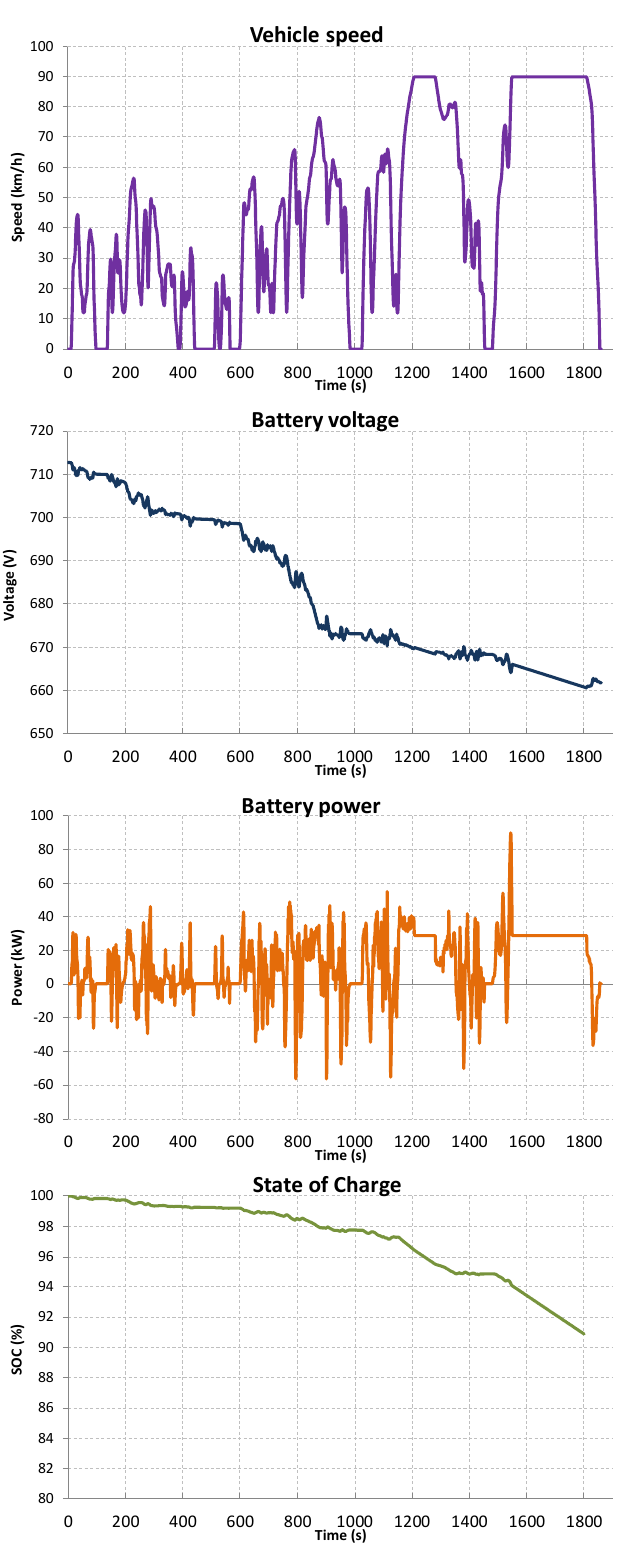
Figure 17. WLTC 3a-90-results of simulation tests for the 4 × 4 drive system.